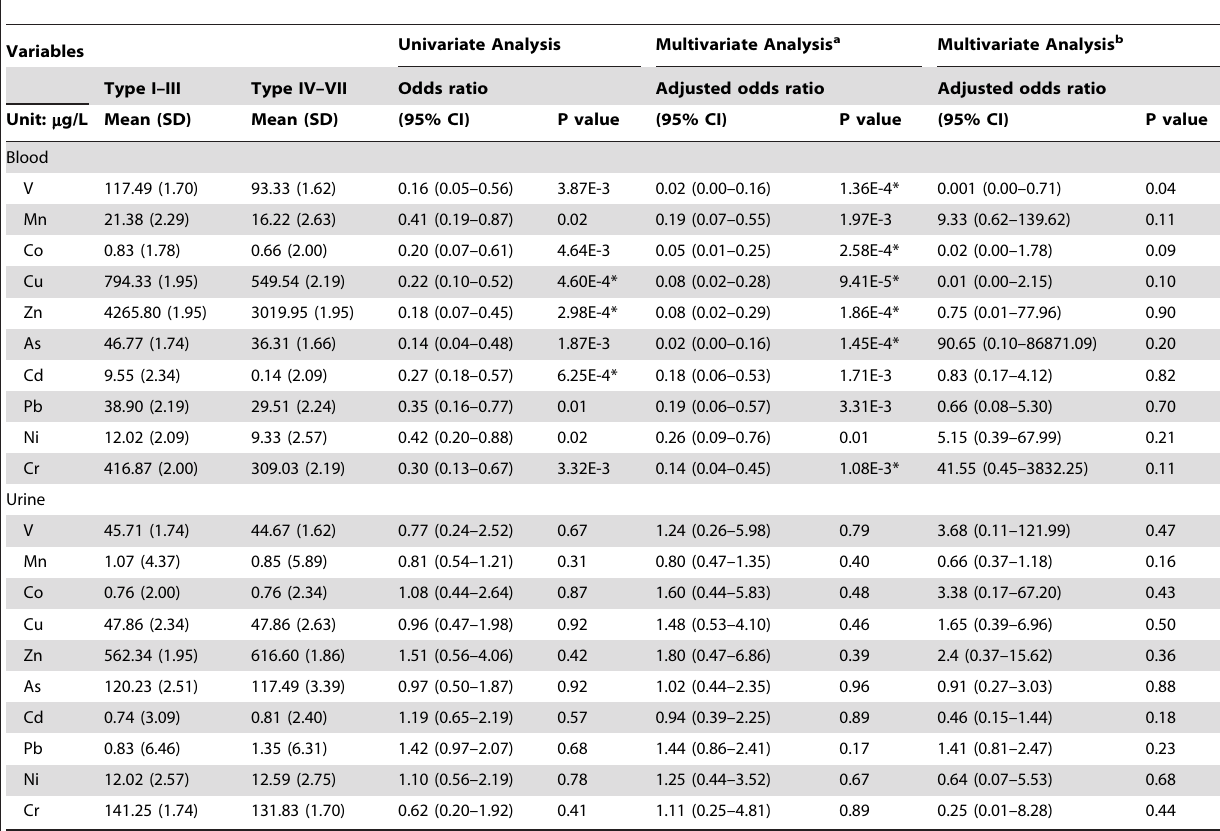
Table 2. Simple and general linear regression of heavy metal concentrations in male subjects with androgenic alopecia.